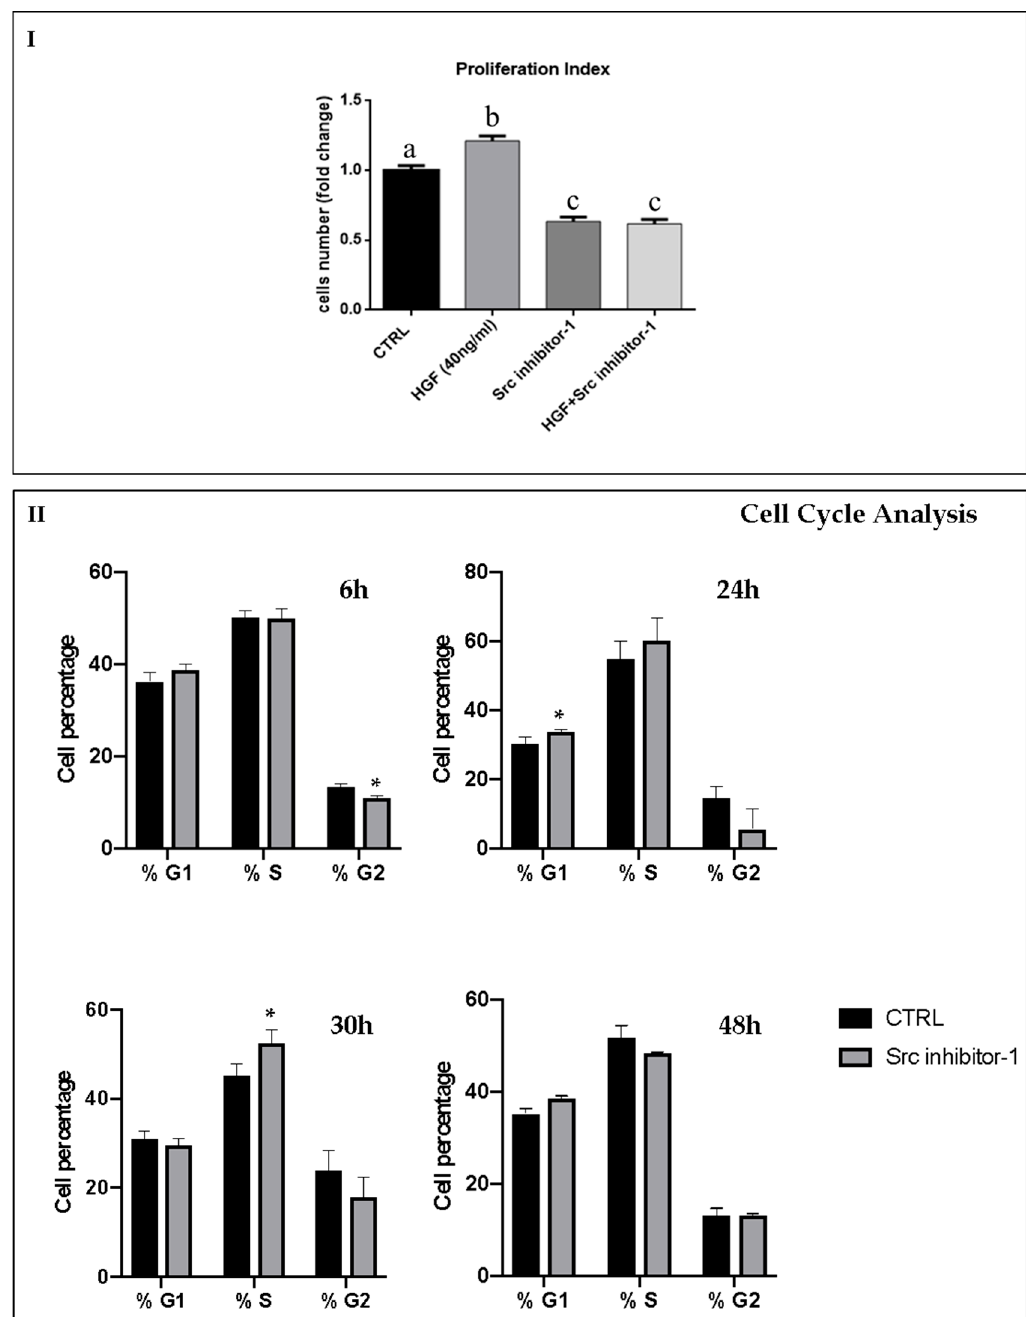
Figure 1. Effect of Src Inbhibitor-1 on NT2D1 cell proliferation induced by HGF. (I) Graphical representation of the number of NT2D1 cells cultured for 48 h in Dulbecco’s Modified Medium (DMEM) + 2% FBS alone (CTRL), or added with HGF, Src inhibitor-1, or their combination. As expected, HGF treatment shows a significant increase of cell number (b vs a p < 0.001). Using the inhibitor, with or without HGF, we demonstrated a significant reduction of cell proliferation both with respect to HGF treatment (c vs b p < 0.001), and to control conditions as well (c vs a p < 0.001). Four independent experiments were performed at least in triplicate. Values were expressed as fold-change being the control considered arbitrarily as 1 (± SEM). (II) Graphical representation of cell cycle analysis on NT2D1 cell cultured for 6, 24, 30 and 48 h with or without Src inhibitor-1. (* vs the respective CTRL condition p < 0.05).